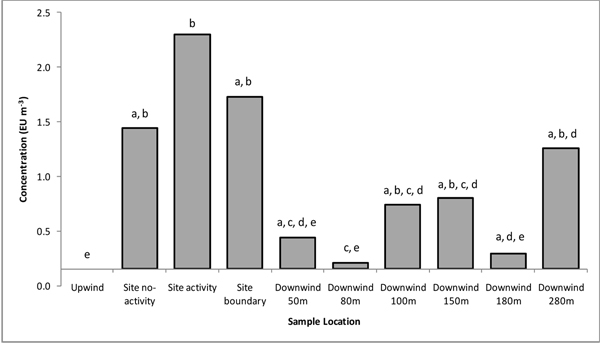
Endotoxin concentrations presented in EU m-3. Bar represents geometric mean, annotations present groups of statistical significance (p =< 0.05). E.g. Within group 'a' there is no statistical difference, while groups 'a' and 'b' are significantly different from each other.X-axis crosses at lower limit of detection, 0.152 EU m-3.